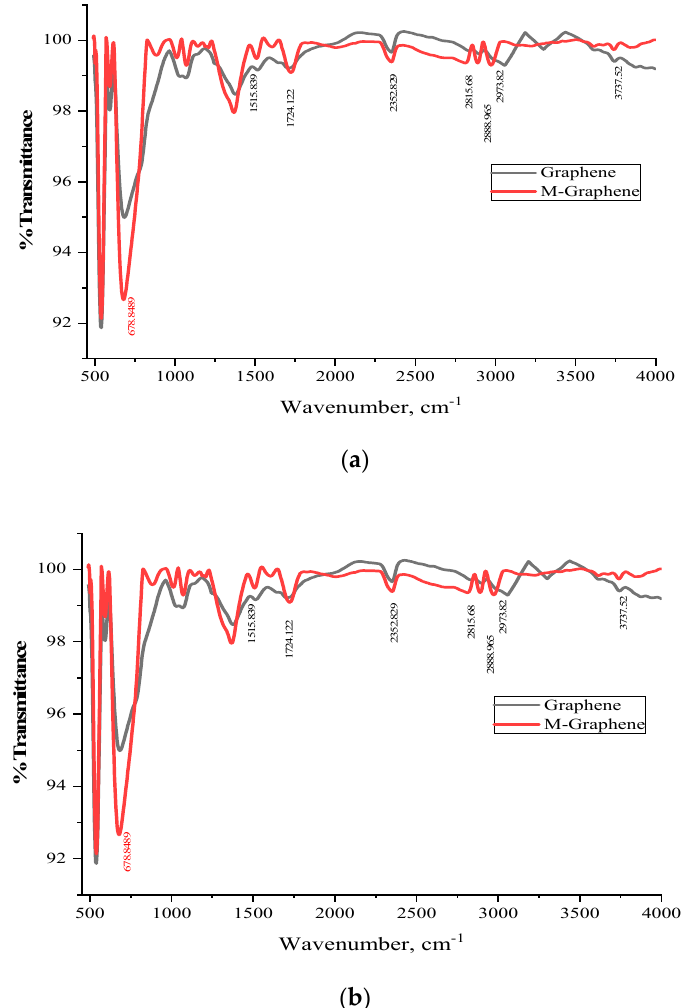
Figure 4. FTIR spectra of pristine and acid − treated ( a ) MWCNT and ( b ) GNF.